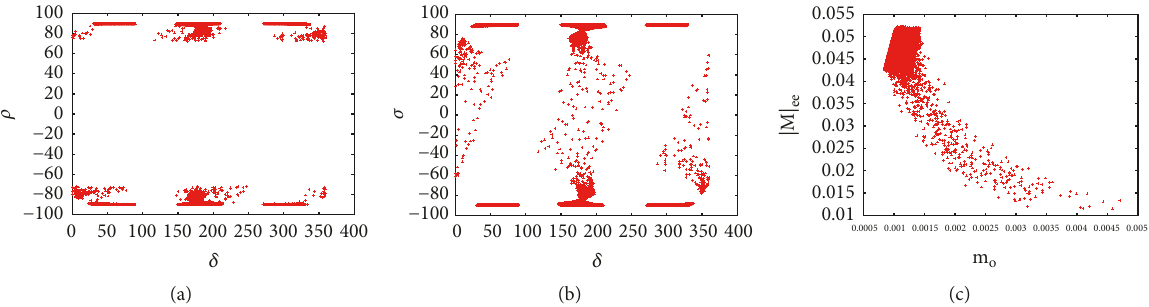
Figure 1: Correlation plots for texture 𝐴 1 (IS) for type X at 3 𝜎 CL. The symbols have their usual meaning. 𝛿, 𝜌 , and 𝜎 are measured in degrees, while |𝑀| 𝑒𝑒 and 𝑚 0 are in eV units.